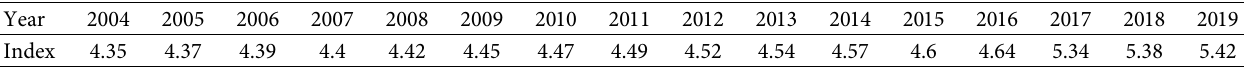
Table 2: IPP intensities of Zhejiang.